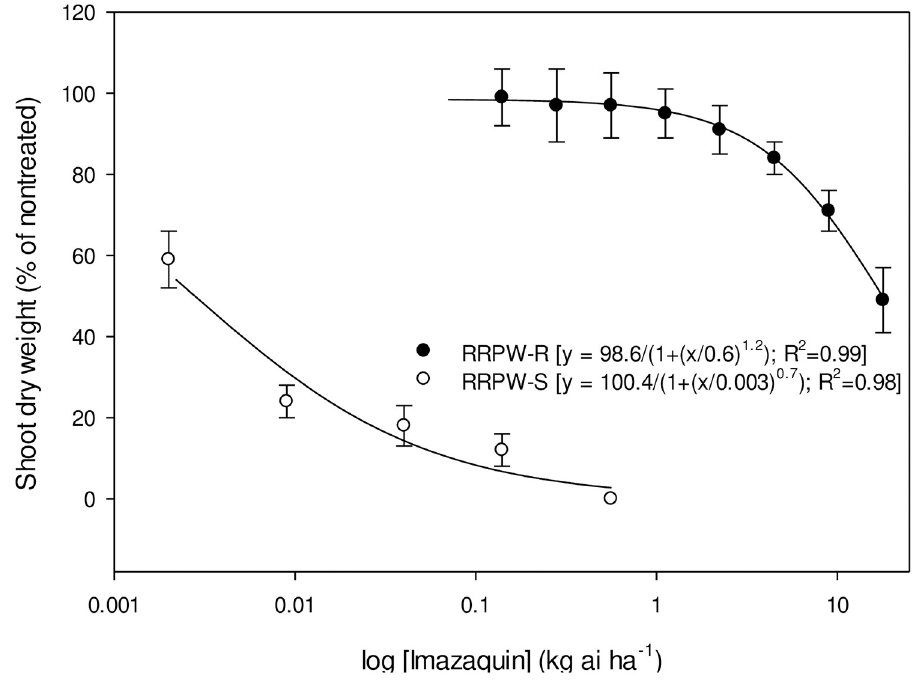
Fig 2. Imazaquin dose response on shoot dry weight reduction of ALS-inhibiting herbicide-resistant (RRPW-R) and -susceptible (RRPW-S) Amaranthus retroflexus populations from Mississippi 3 wk after treatment. Vertical bars represent standard error of mean.